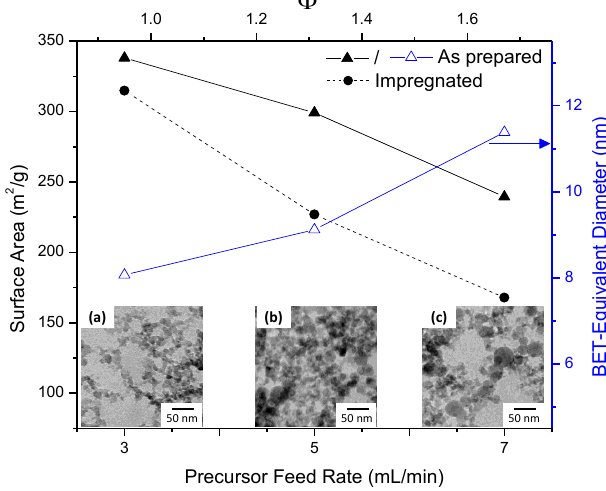
Figure 1. Impact of precursor feed rate and fuel equivalence ratio (Φ) on specific surface area and Brunauer-Emmett-Teller (BET)-equivalent diameter of flame spray pyrolysis (FSP)-produced silica; as prepared, and after 5% Ni impregnation and calcination. Included are TEM micrographs of FSP ( a ) 3, ( b ) 5 and ( c ) 7-SiO 2